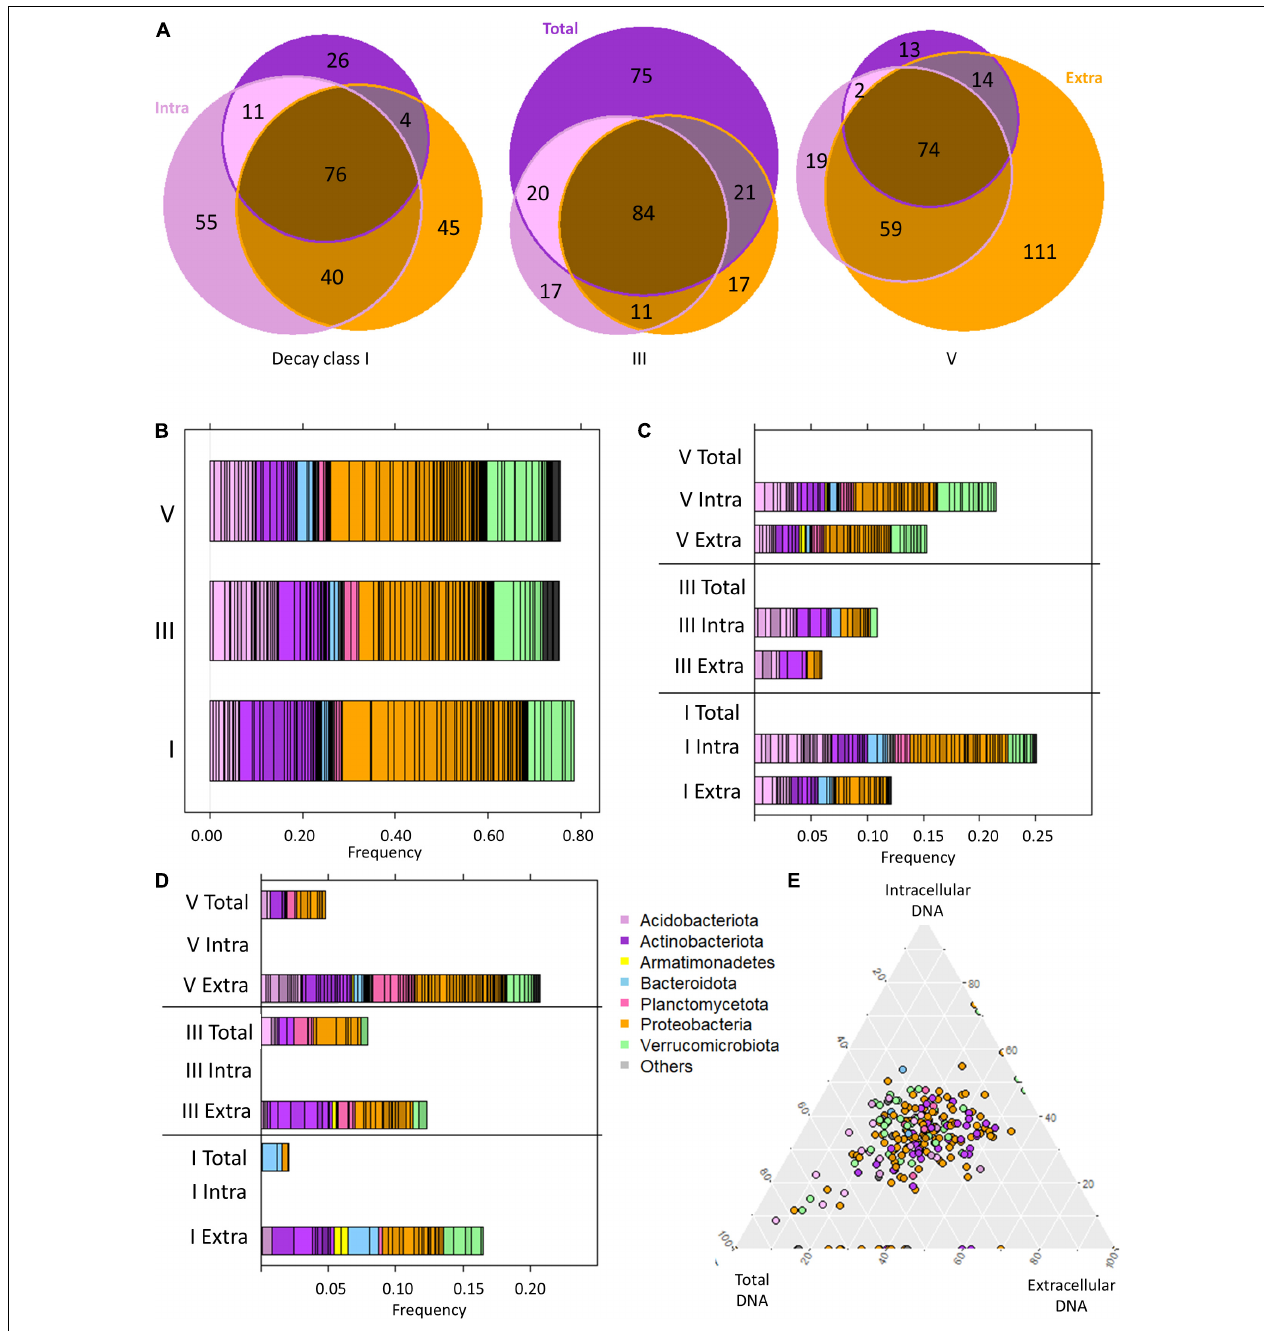
FIGURE 4 | The bacteriome of Picea abies deadwood across decay classes (DCls I, III, V) and DNA types (extracellular and intracellular DNA fraction, total DNA pool). (A) Venn diagram illustrating the ASV occurrences among DNA types within each DCl. (B) Taxonomic composition of P. abies bacteriomes among DCls based on only the intracellular DNA fraction. (C) Taxonomic overview of ASVs that remained undetected in the total DNA pool within a DCl. (D) Taxonomic overview of ASVs that remained undetected in the intracellular DNA fraction within a DCl. (E) Ternary diagram of those ASVs with differential abundance among DCls (see Figure 2 and Supplementary Table 1 ). Their proportionate abundance among DNA types is